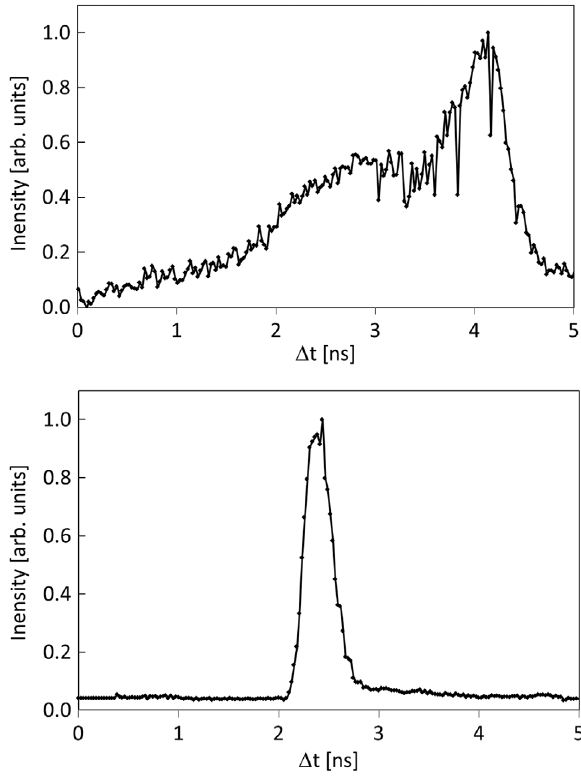
heavyFIG. 18. Bunch shape of Ar 9 þ -beam emittance at 1 . 366 MeV/u (top) and fully matched at 1 . 85 MeV/u (bottom); the FWHM of is measured for 0.5